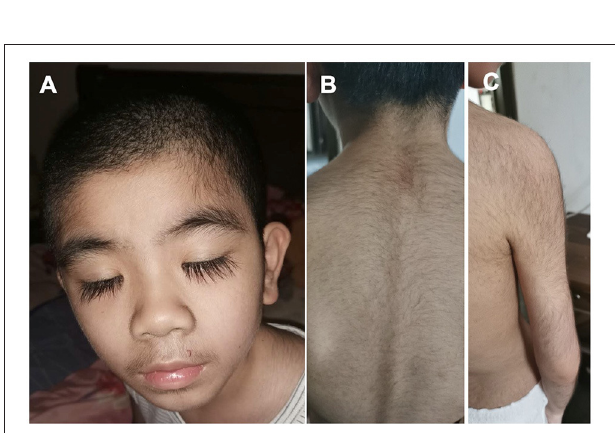
FIGURE 2 | Dysmorphic features of the Patient #2 with de novo KCNT2 variant at the age of 10 years. (A) Facial Gestalt of thick hair, prominent eyebrows, and long and thick eyelashes. (B) Thick hair on the back. (C) Thick hair on the right